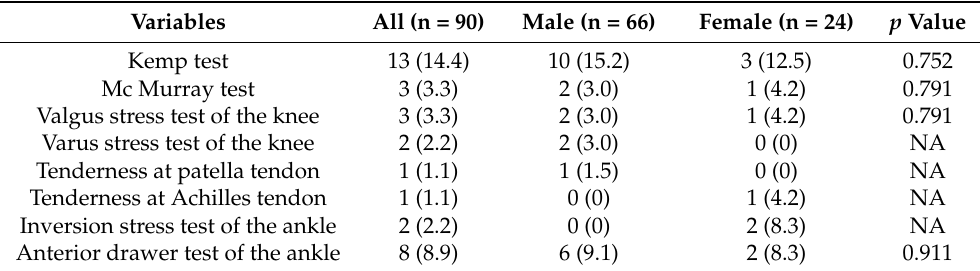
Table 4. Results of physical examinations of the spine and lower extremities (category